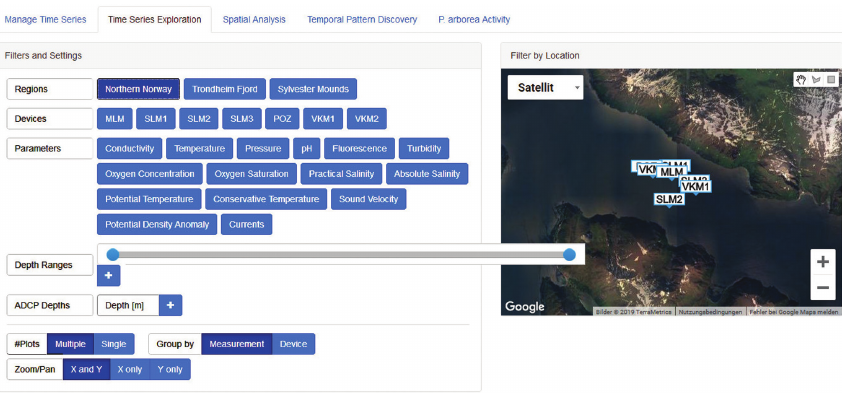
Fig. 2: GUI with labels for selecting a map area (example from